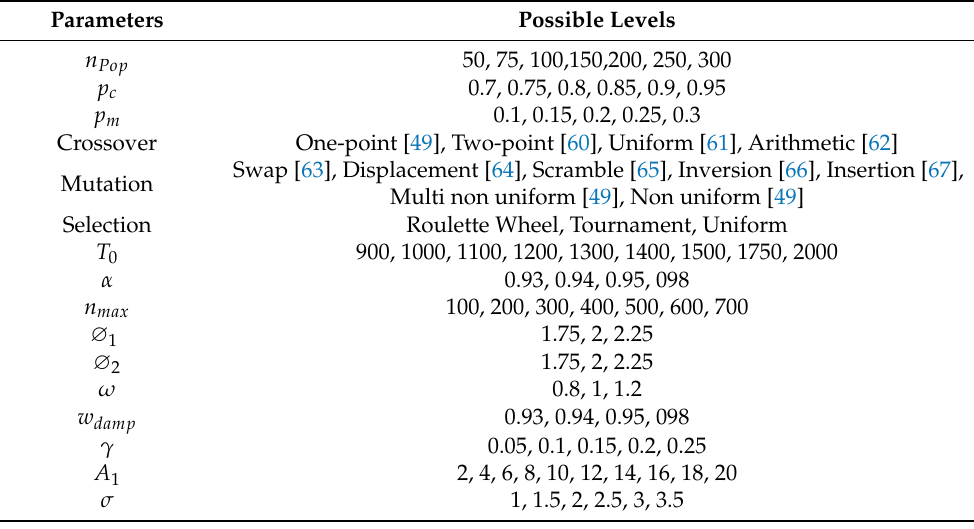
Table A4. Possible levels for the parameters of the proposed